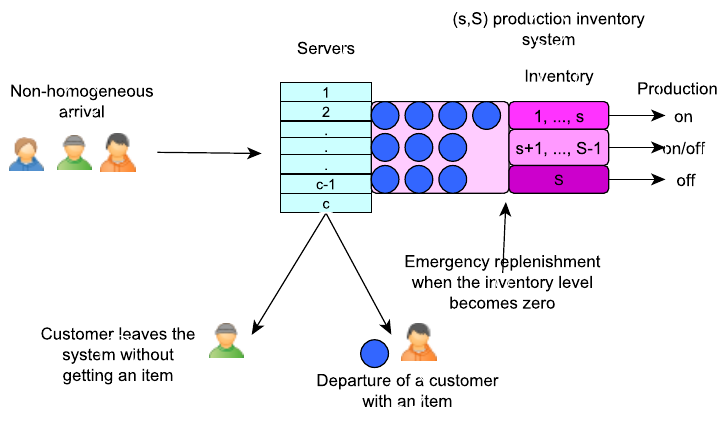
Figure 1. Picture representation of the